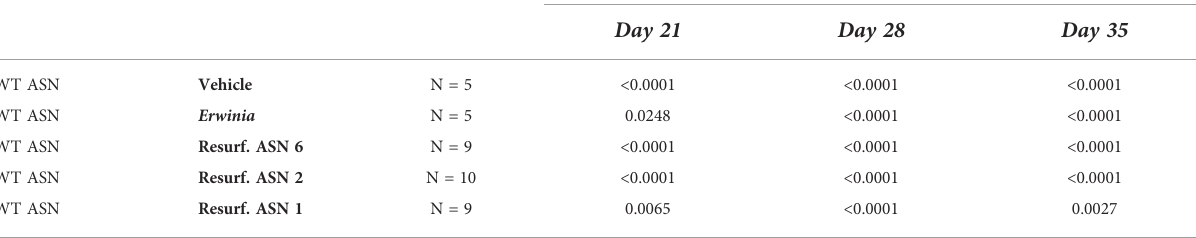
TABLE 3 Resurf. ASNs signi fi cantly reduced hypersensitivity responses In vivo . Sensitization Group Challenge Group Number of mice P -value from one-way ANOVA compared to WT ASN challenge group